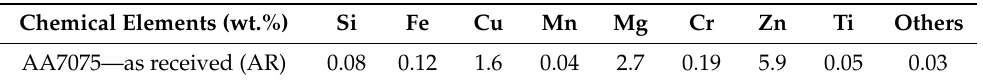
Table 1. Chemical composition of the investigated alloy AA7075 determined by optical emission spectroscopy, according to AMAG (Austria Metal